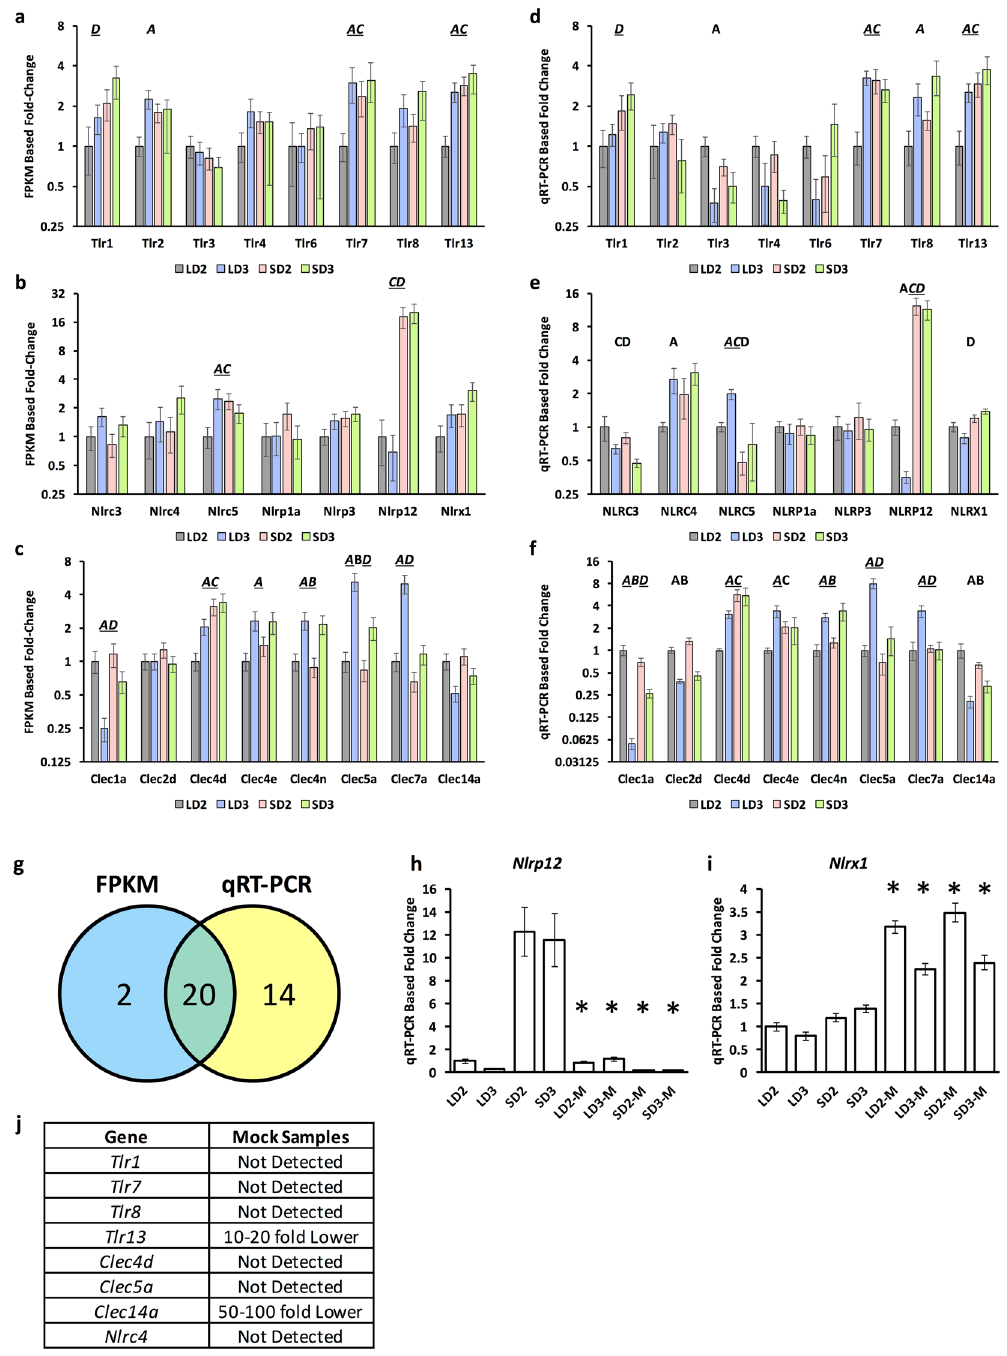
Figure 3. RT-qPCR analysis of murine genes differentially expressed during IPA. Fold change was determined for differentially expressed and expressed ( a,d ) Toll-like receptors, ( b,e ) Nod-like proteins, ( c,f ) and C-type lectins via FPKM analysis and RT-qPCR analysis respectively. Fold-change for RT-qPCR was normalized using β -tubulin , and related to LD2 gene expression (comparator) using the ΔΔ CT method. For FPKM based analysis, data is presented in relation to LD2 gene expression (comparator). Statistical significance is indicated for instances where p < 0.05. A/B statistically significant differential expression between day 2 and day 3 for the chemotherapeutic/steroid model respectively. C/D, statistically significant differential expression between the chemotherapeutic and steroid model for day 2/day 3 respectively. Underlined letters indicate statistical significance by both FPKM and RT-qPCR. ( g ) Summary of total instances of differential gene expression between FPKM and RT-qPCR based methods. Gene expression of (h) Nlrp12 and ( i ) Nlrx1 in inoculated and mock ( − M) inoculated samples. Statistical significance ( * ) is indicated where p < 0.05 for comparisons between a mock and inoculated sample. ( j ) Summary of analyzed genes from mock samples not expressed or expressed at a significantly lower level ( > 10-fold decrease in expression in comparison to inoculated sample). Steroid Model, S; Chemotherapeutic Model, L; Day 2, D2; Day 3,